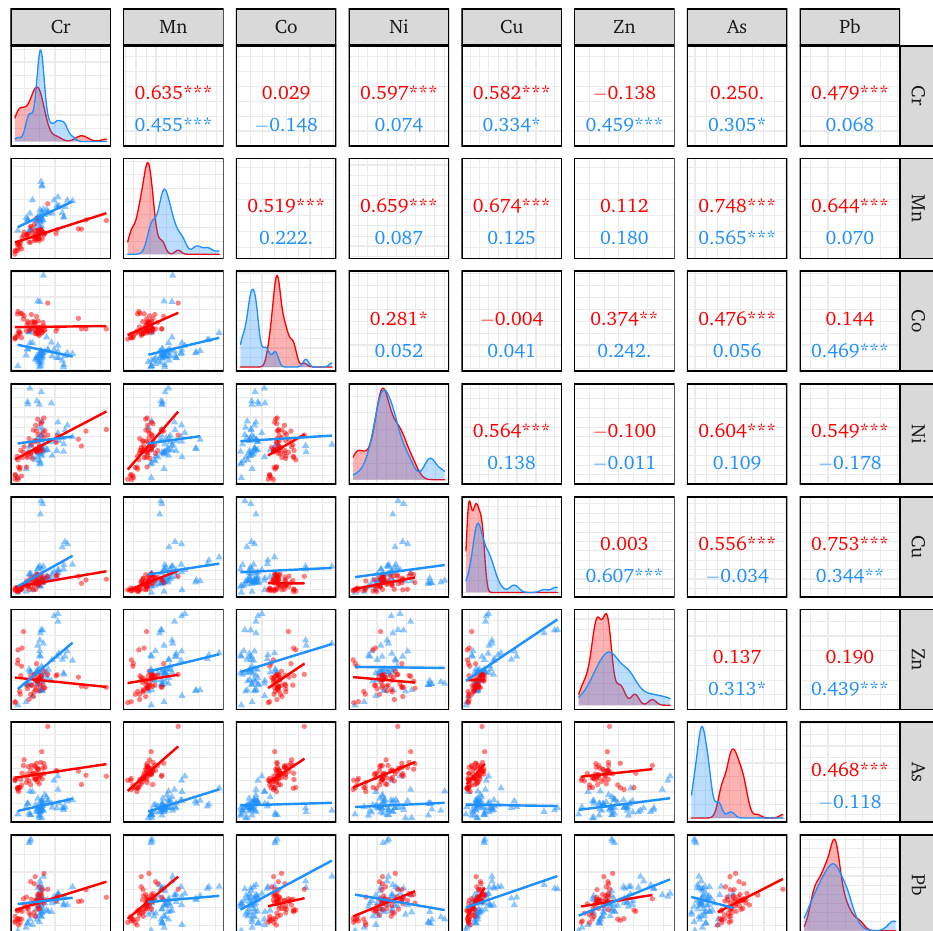
Figure 3. Correlation matrix of heavy metal concentrations in roadside dust of Dhaka City of Bangladesh. The values in the upper and lower matrices are Spearman’s rank correlation co-efficient ( ρ ) and metal concentrations, respectively. Red and blue colors represent summer and winter seasons, respectively. Spearman’s rank correlation co-efficient values ( ρ ) with *, **, and *** denoting significant at 95%, 99%, and <99% levels of significance. The diagonal matrix (density plots) shows the distribution of